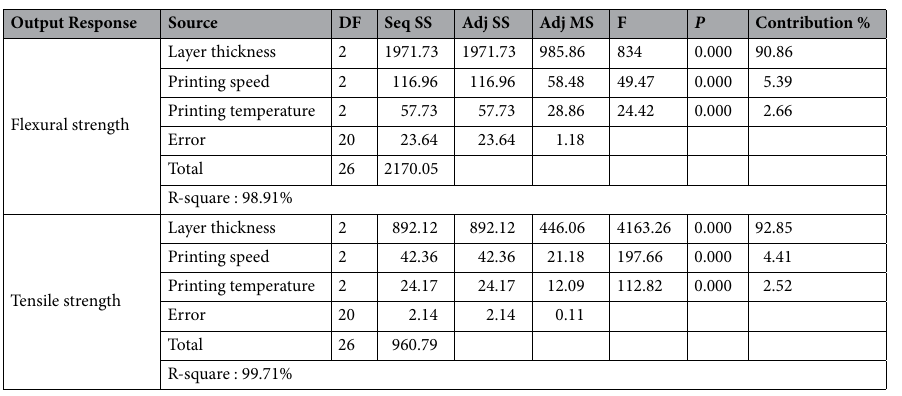
Table 4. Analysis of variance (ANOVA) and percentage contribution of input factors on output